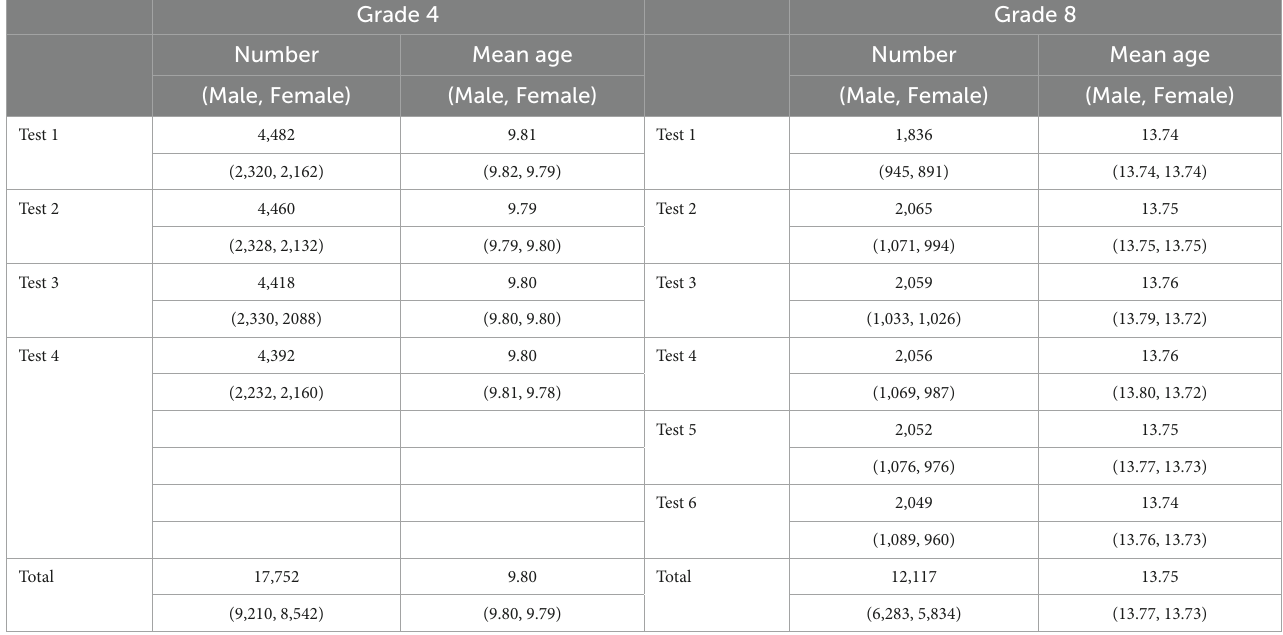
TABLE 6 Sample size and mean age (years) by gender, grade level, and science test